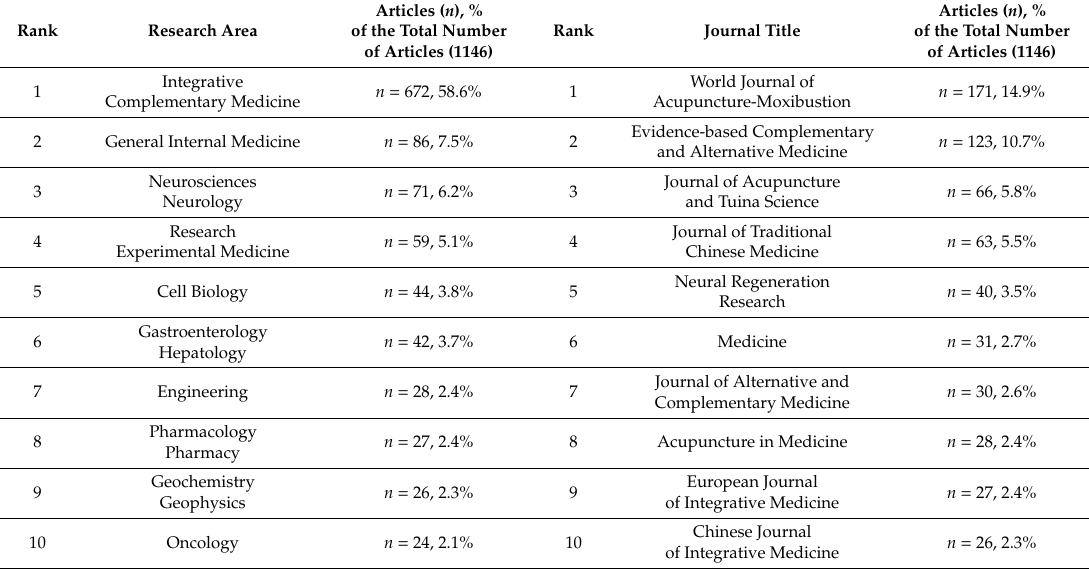
Table 2. The top 10 research areas and journals that have produced the highest number of original and review articles investigating